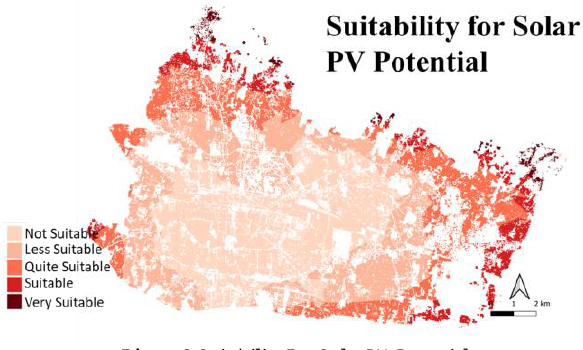
Figure 3 Suitability For Solar PV